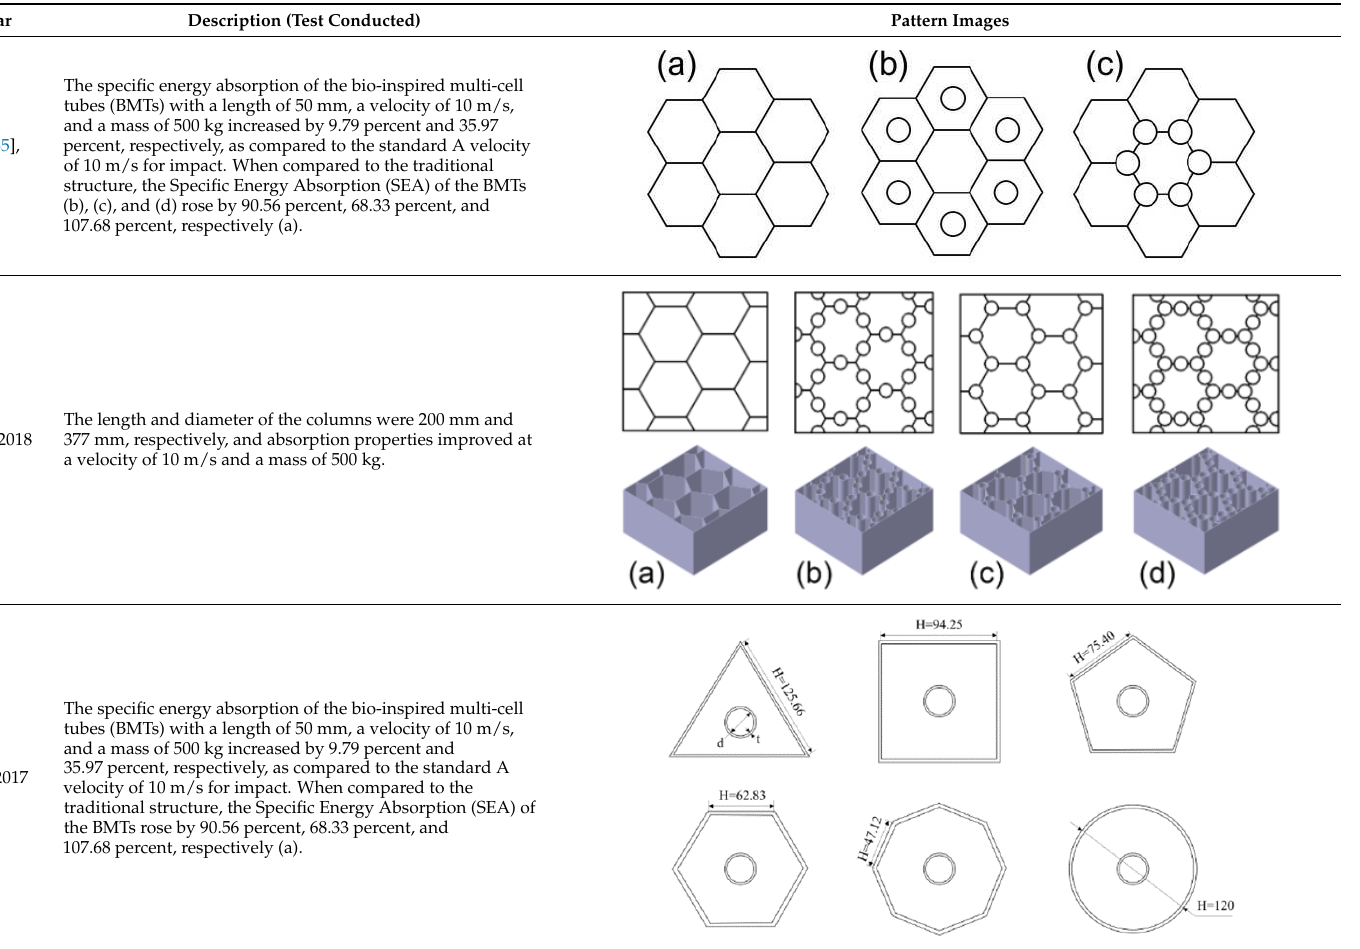
Table 1. Bio-inspired design models built by predecessor authors.